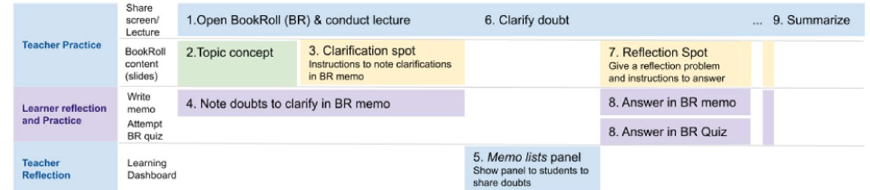
Fig. 7 Integrated view of LeD focus phase orchestrated in the TEEL